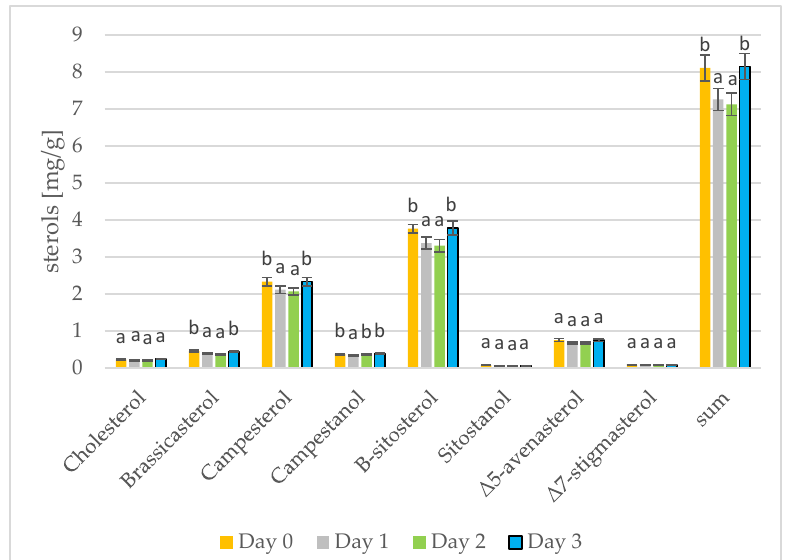
Figure 4. Levels of individual phytosterols [mg/g oil] in mustard oils at different stages of germina- tion (days 0, 1, 2, 3) (values are means ± SD from three experiments. Values with different letters are significantly different ( p < 0.05)).